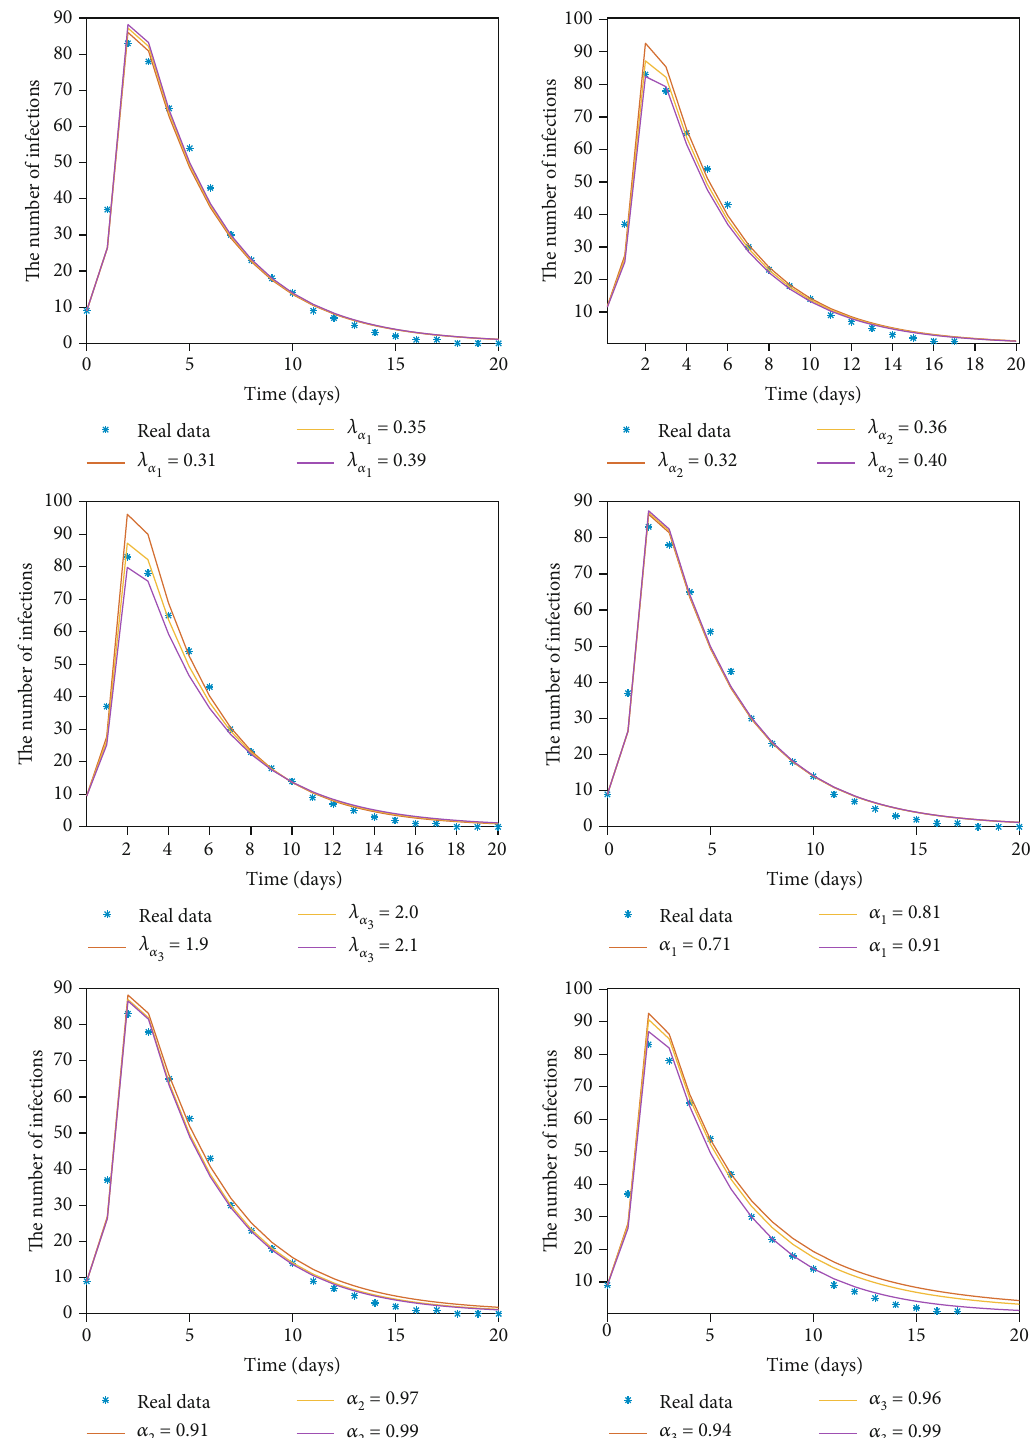
, α ð i = 1, 2, 3 Þ on the quantity of infections I ð t Þ when the remaining parameters remain α i i